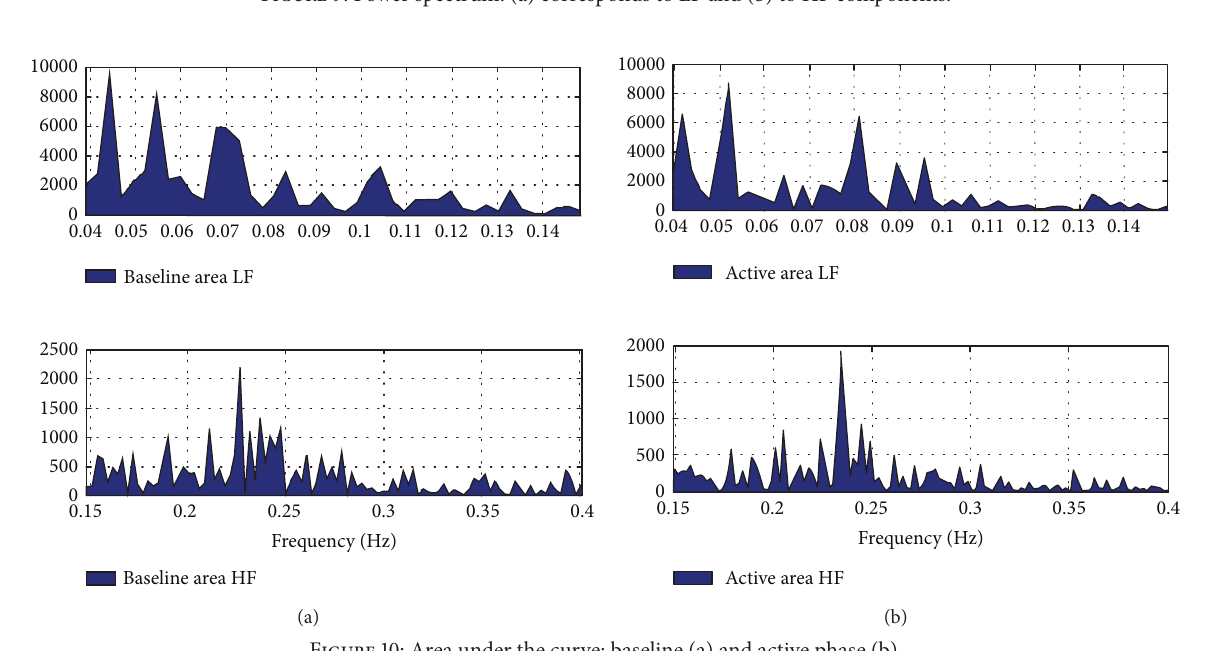
Figure 10: Area under the curve: baseline (a) and active phase